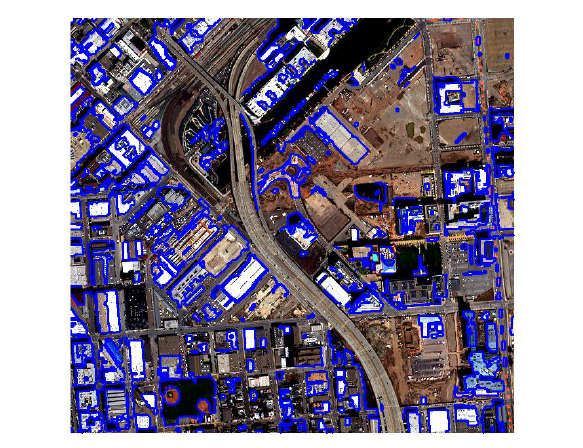
Figure 2. The resultant building detection in a WorldView2 image.